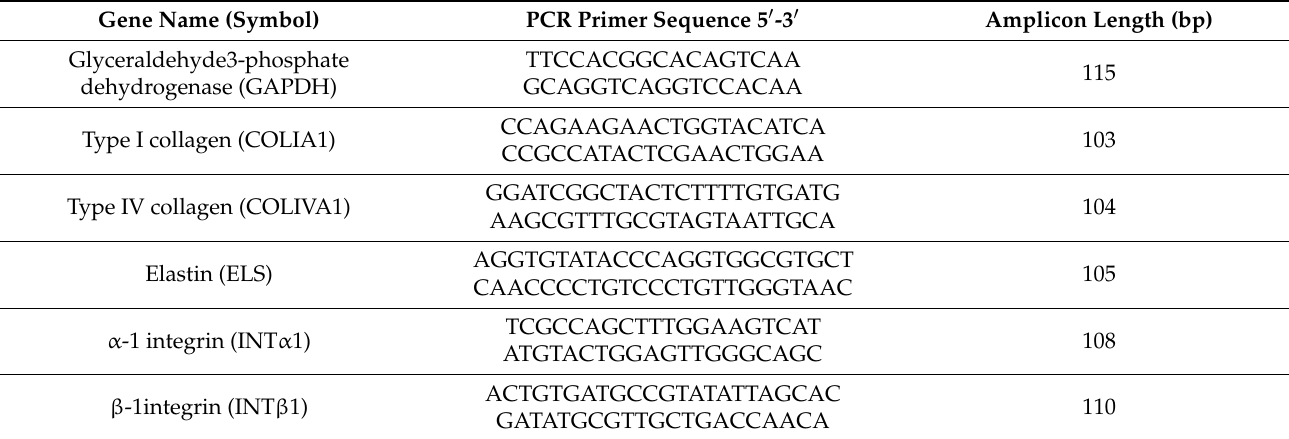
Table 3. Primers sequence used for qRT-PCR